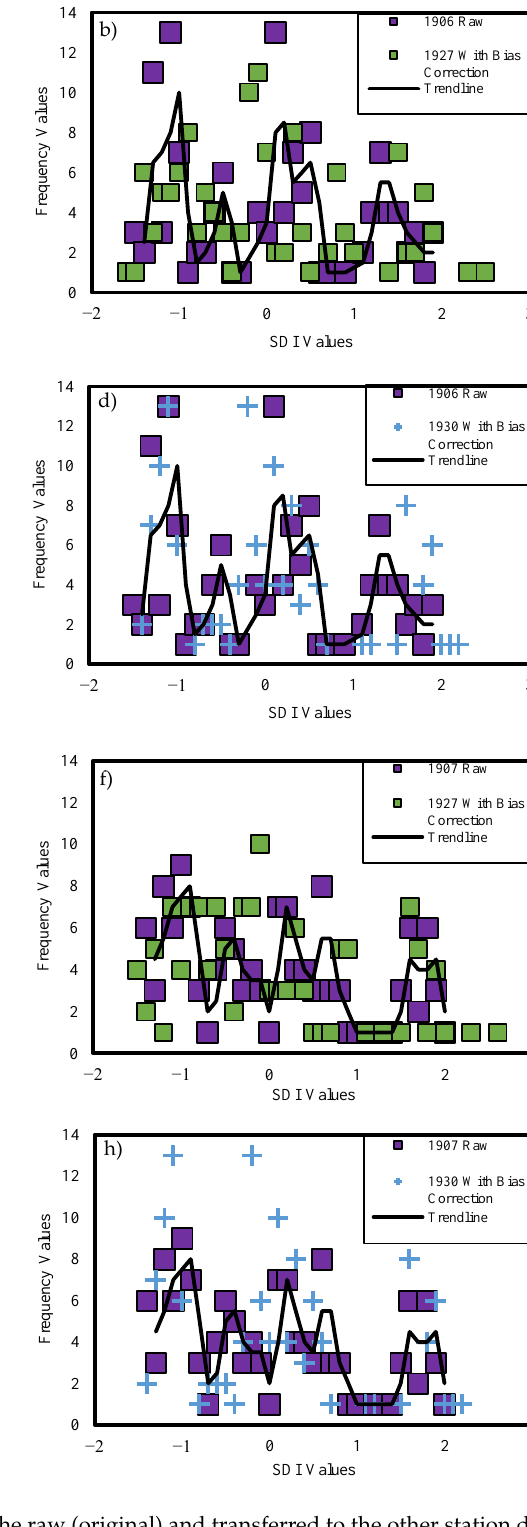
Figure 11. Frequency values for the raw (original) and transferred to the other station data with bias correction. (a) 1926 and 1906, (b)1927 and 1906, (c) 1928 and 1906, (d) 1930 and 1906, (e) 1926 and 1907, (f)1927 and 1907, (g) 1928 and 1907, (h) 1930 and 1907 It can be seen in these graphs that the results of the D19A028 station and the target station values showed little convergence. In addition, according to the trend line created for the original SDI frequency values, no more than two indexes were found, while it is possible to see larger values in the transported SDI values. This can be expressed as dry